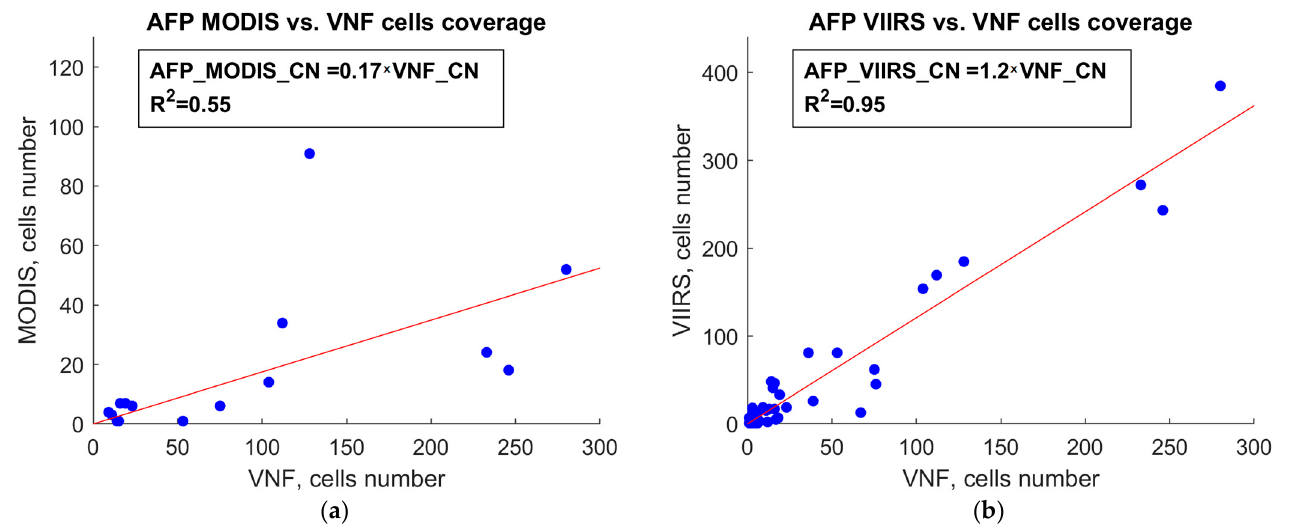
Figure 16. Comparison of VNF and AFP detection probability of forest fires: ( a ) VNF vs MODIS AFP; ( b ) VNF vs VIIRS AFP.